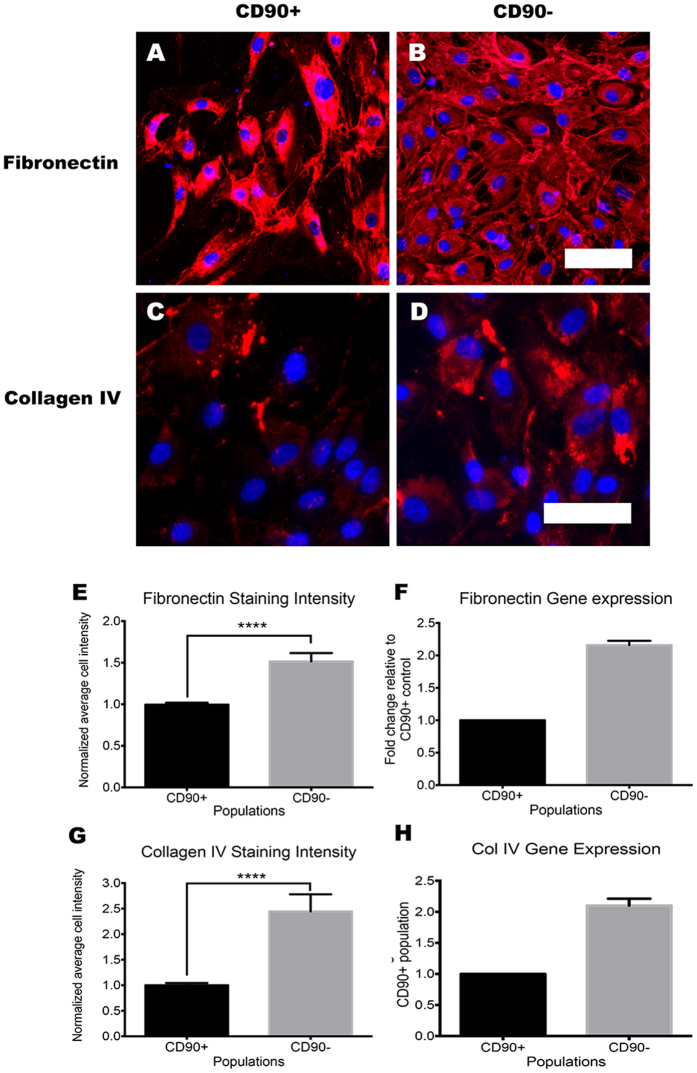
CD90− population expressed greater amounts of extracellular matrix compared to CD90+ population.Photomicrographs of CD90+ and CD90− population immunolabeled for extracellular matrix components fibronectin and collagen IV (A–D). Clearly visible is the larger amount of fibronectin deposited in the CD90− cultures compared to that of the CD90+ population (A,B) and this was quantified by analyzing the average fibronectin intensity per cell ((E) p < 0.001). The level of fibronectin mRNA expression corroborated these finding with CD90− having at least twice the basal mRNA expression levels compared to CD90+ population (F). Collagen IV expression was also higher in the CD90− population, as demonstrated by immunolabeling (C,D), image analysis (G) and mRNA expression (H). Photomicrographs are representative images from three separate cases, while image analysis and gene expression data are pooled from at least three cases. Scale = 100 μm. ****p < 0.0001.